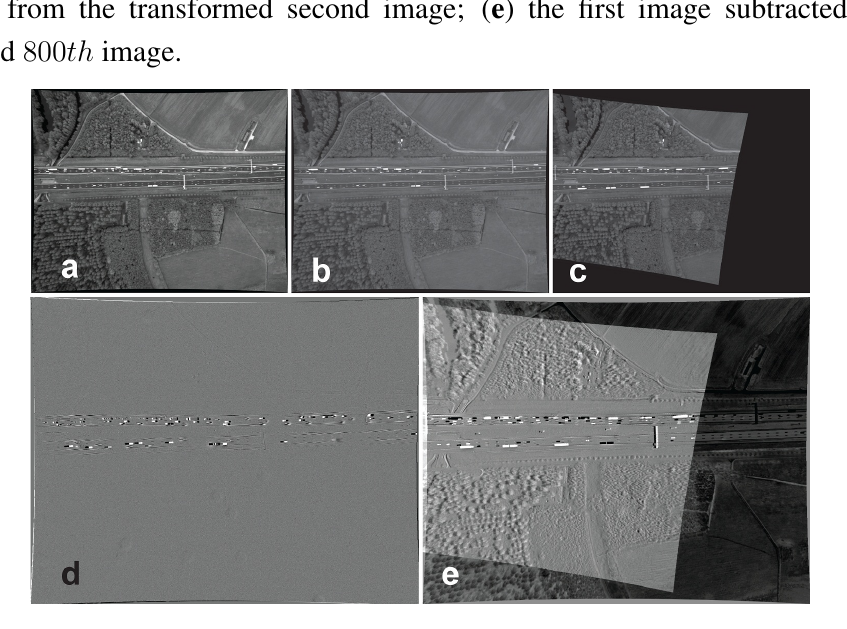
Difference images after registration: ( a ) the reference image (first image); ( b ) the transformed second image; ( c ) the transformed 800 th image; ( d ) the first